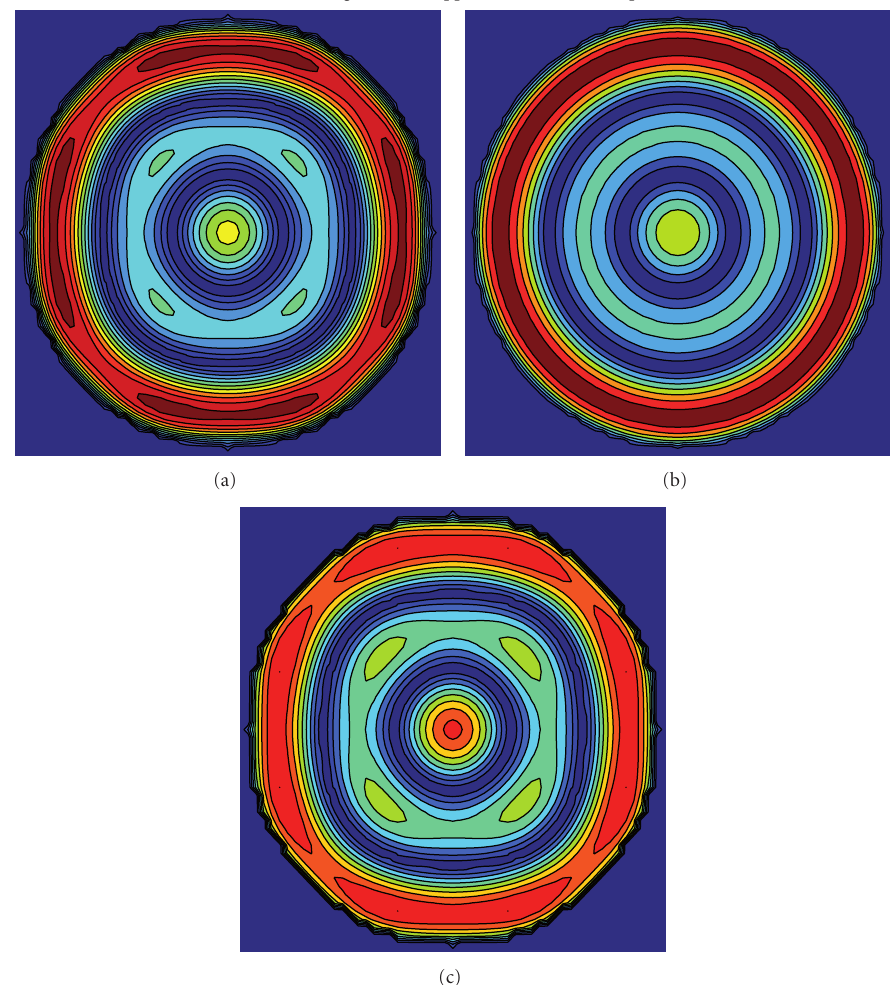
Figure 5: See the caption of Figure 3. The error for the sixth-order approximation for (a) Section 5 with D2V81 is slightly anisotropic while for (b) Section 5 with D2V141 the error is isotropic. The error for the eighth-order approximation for (c) Section 5 with D2V141 also exhibits small anisotropic patterns. The theoretically predicted isotropy properties are hence numerically confirmed. The colors are not scaled between the